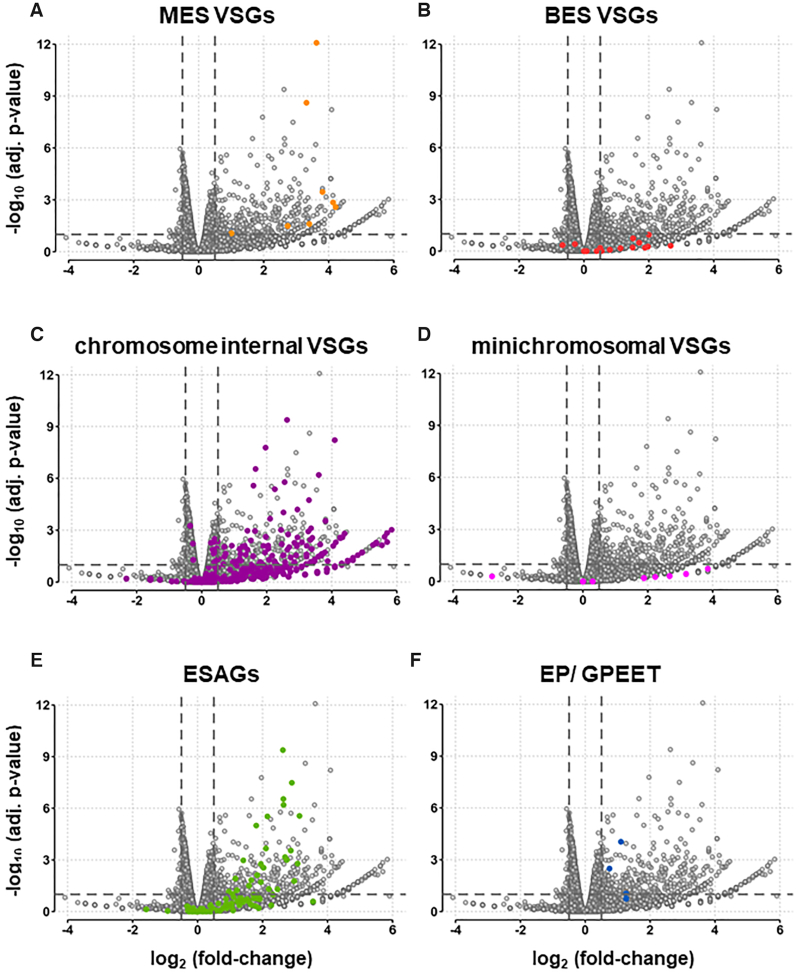
Knock-down of TbSAP leads to striking up-regulation of both VSGs and ESAGs with relatively few downregulated transcripts. (A) Volcano plot showing differential gene expression after induction of TbSAP RNAi for 72 h compared with the parental T. brucei MES-GFP cell line. Dots indicate individual transcripts with those corresponding to MES VSGs indicated in light orange. Results are plotted as log2 (fold change) of read count values versus adjusted P-value. Thresholds at adjusted P-value ≤0.1 and fold change ≥1.4 are shown (dashed lines). Values were calculated from three biological replicates of each dataset. The other panels are as in (A), only in panel (B) VSGs located in BESs are highlighted with dark orange dots, panel (C), chromosome internal (CI) VSGs located within the silent VSG arrays are highlighted with purple, panel (D) VSGs located on minichromosomes are indicated with pink dots, panel (E) ESAGs are indicated in green dots and panel (F) the EP and procyclin transcripts are indicated with blue dots.